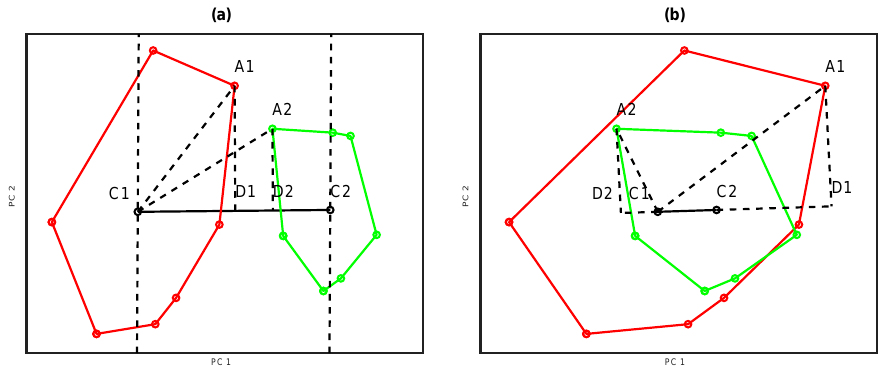
Figure 3. Key points (A1, A2, C1, C2, D1, D2) used in the calculation of relative position (RP) parameter characterizing the distance between the “green” and “red” classes: ( a ) separated classes, ( b ) merged classes.